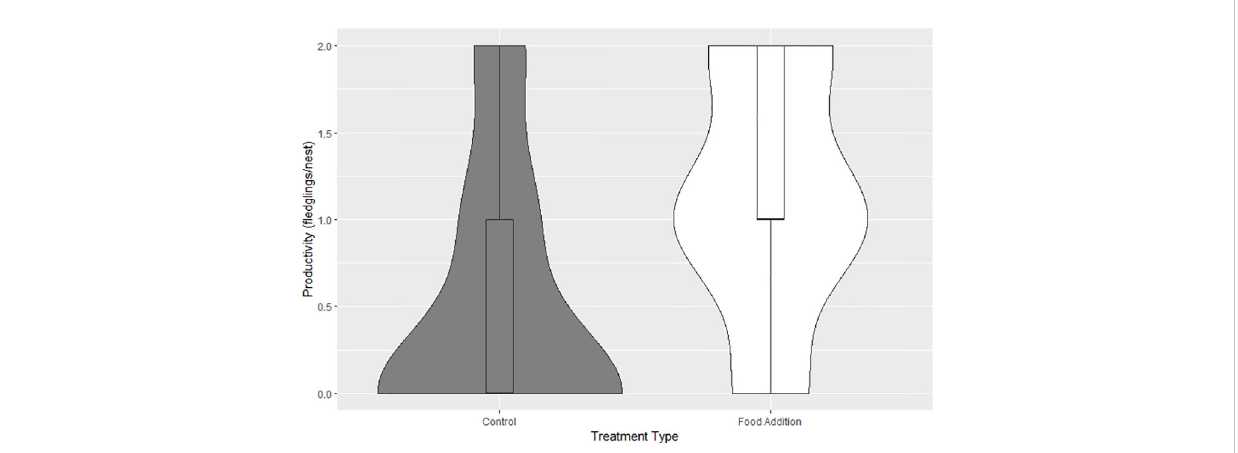
FIGURE 2 Productivity between the control group (N = 15) and the treatment group (N = 16) of ospreys during the 2021 breeding season in the lower Chesapeake Bay, VA, USA ( b = 0.88, SE = 0.45, pseudo R 2 = 0.14, CI =0.049, 1.825, P = 0.048). Violin shapes represent the density of data distribution and the middle horizonal line of the box plots represent the median